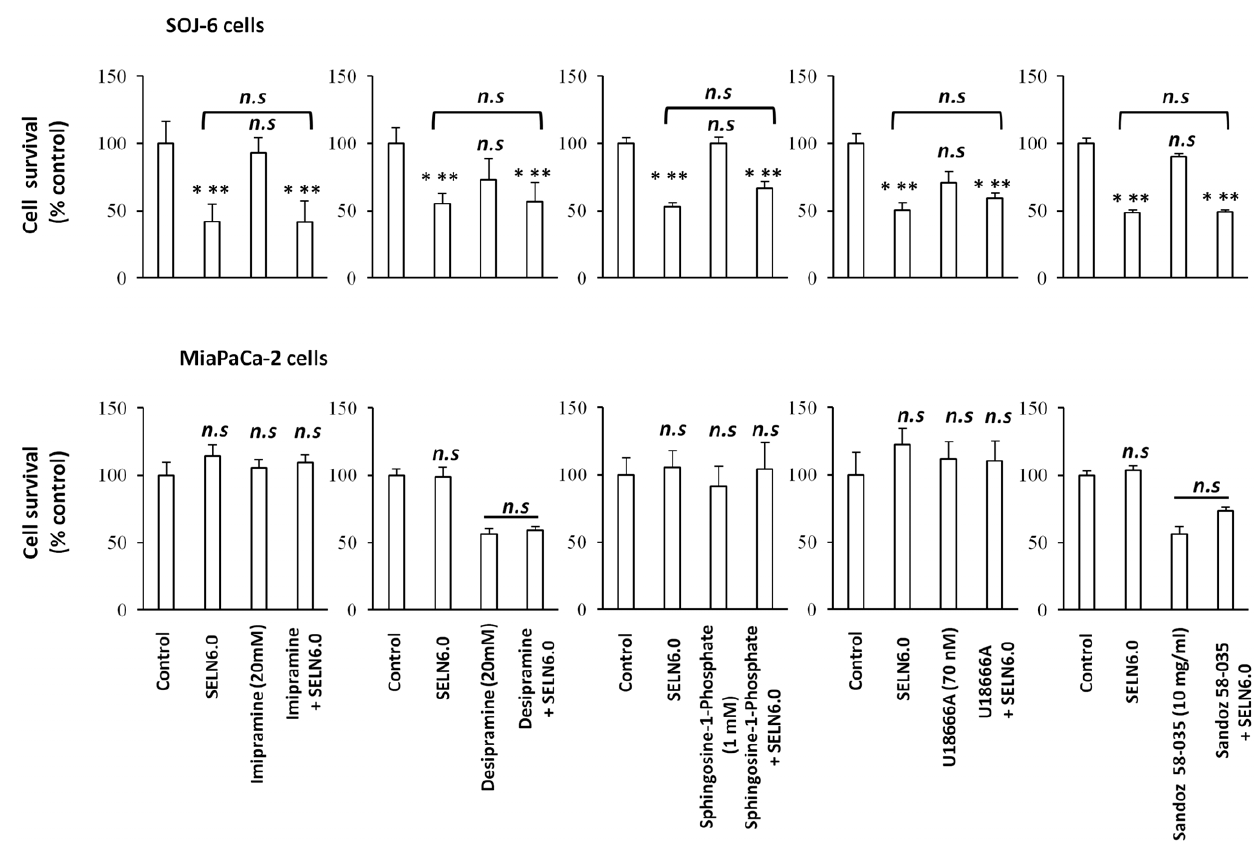
Figure 6. Proliferation of MiaPaCa-2 and SOJ-6 cells in the presence of drugs. MiaPaCa-2 and SOJ-6 cells were incubated 1h with drugs affecting lipid metabolism at the indicated concentration then SELN6.0 (16 nmoles cholesterol/ml) were added for 24h in the presence or absence (control) of drugs at indicated concentration. At the end of incubation, proliferation was measured by MTT assay and expressed as % of control. Results are means ( 6 SD) of independent experiments, (n=24, Student’s t -test).